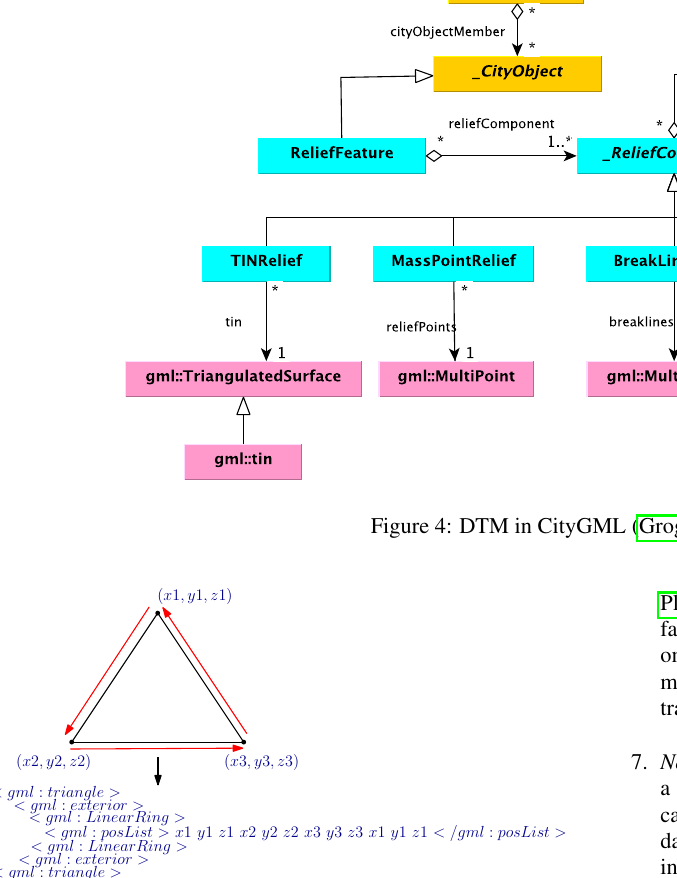
Figure 5: OGC Simple